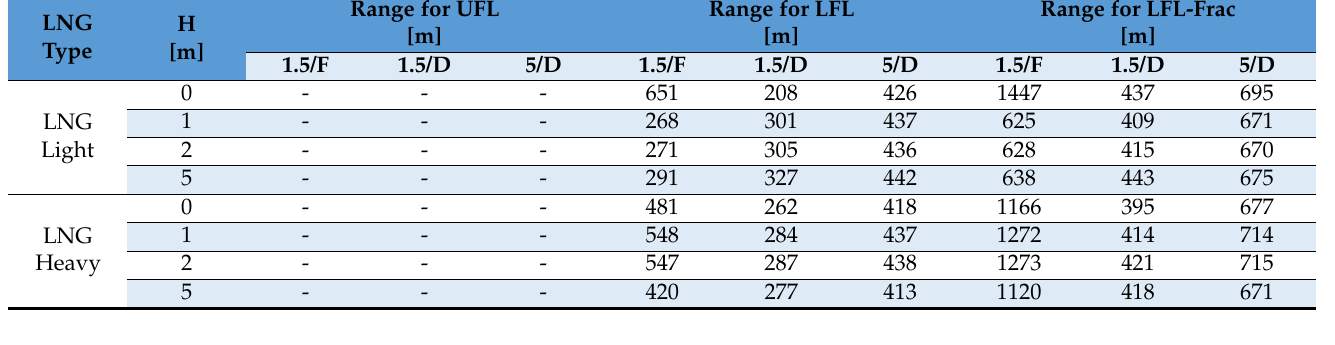
Table 5. Flash fire envelope, range for LFL and LFL-Fraction.